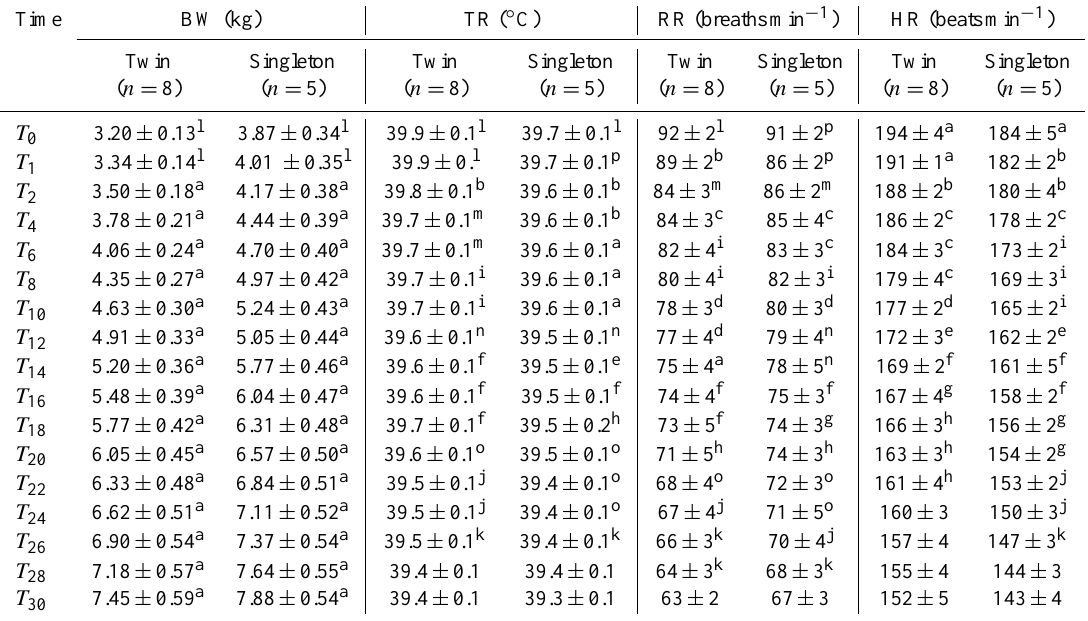
Table 2. Mean ± standard deviation of body weight (BW), rectal temperature (TR), respiratory rate (RR) and heart rate (HR) values measured in twin and singleton kids at each time points ( T 0 – T 30 ) of experimental